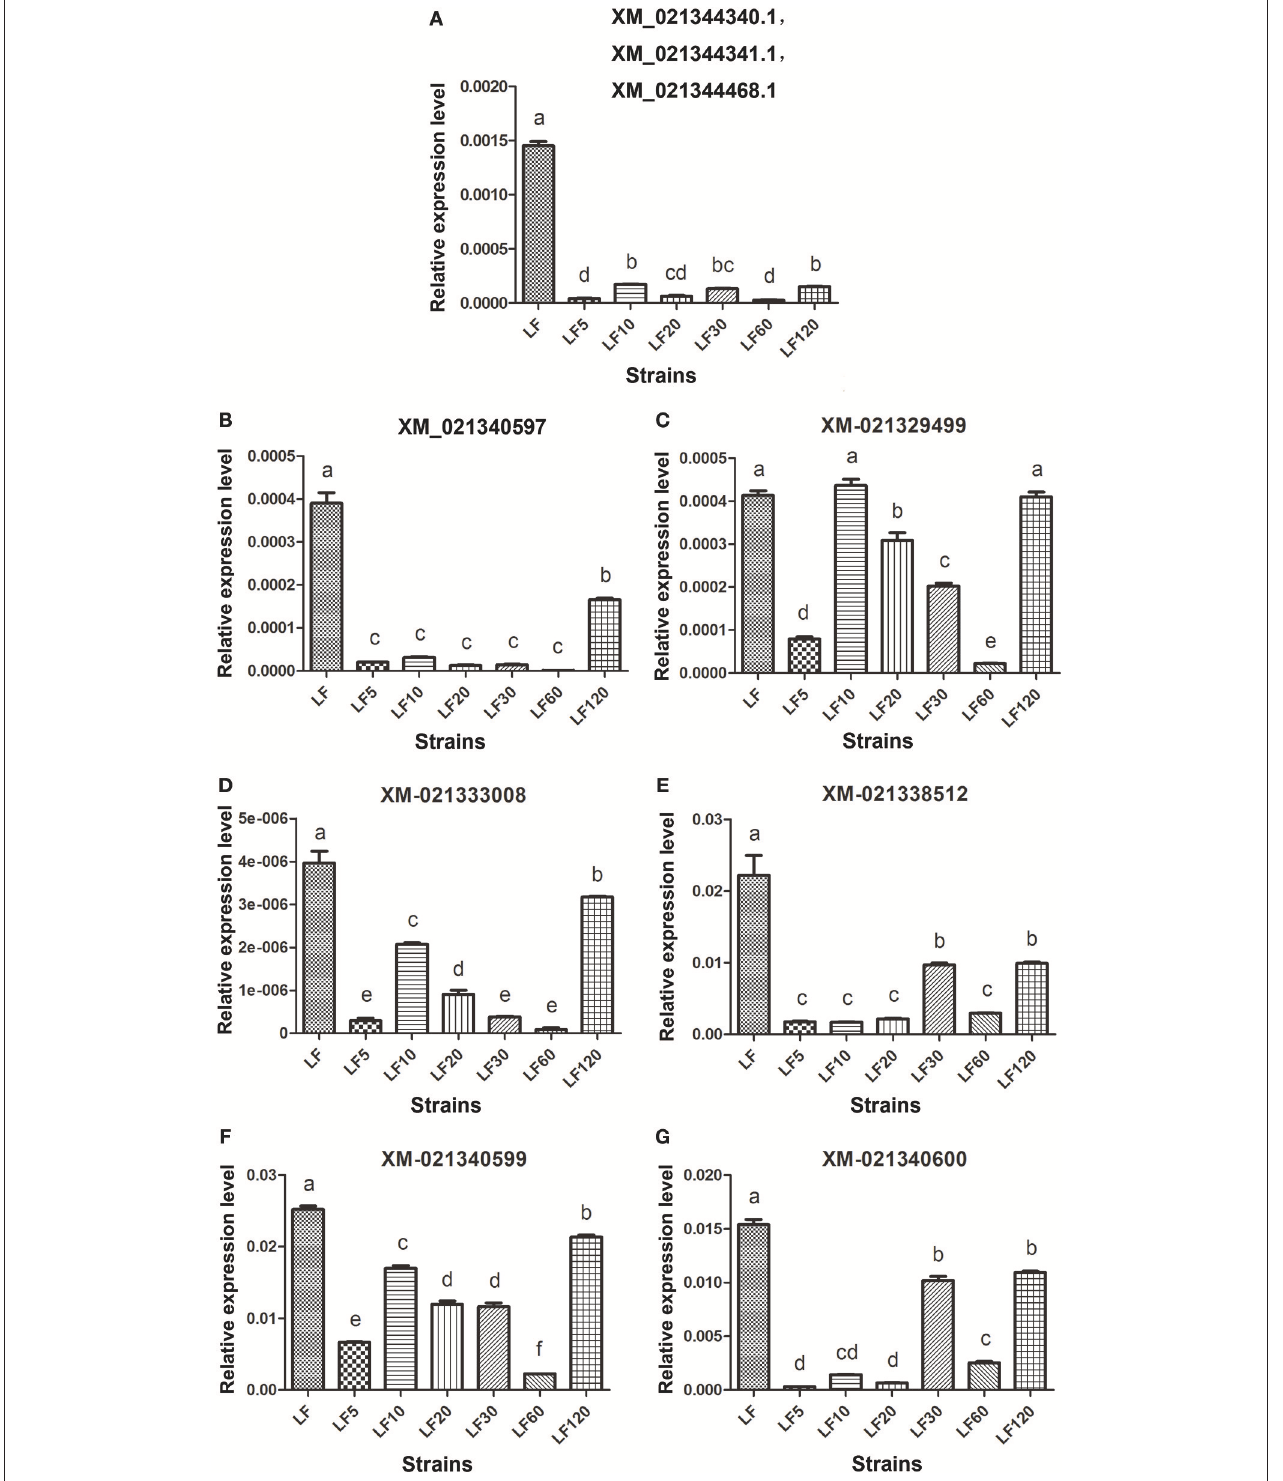
FIGURE 3 | The qRT-PCR analysis of transcript abundances among candidate Bt resistance trypsin genes within H. armigera -susceptible (LF) and -resistant (LF5, LF10, LF20, LF30, LF60, and LF120) strains. (A) The three genes ID numbers represent the three trypsin genes in NCBI; a pair of primers in the conserved region of these three trypsin genes were used to analyze transcript abundances. (B-G) Represent the relative expression levels of trypsin genes of XM_021340597, XM_021329499, XM_021333008, XM_021338512, XM_021340599 and XM_021340600 in resistance strains, respectively. Values shown are means and standard errors. Different letters indicate significant differences between treatments ( P < 0.05; HSD